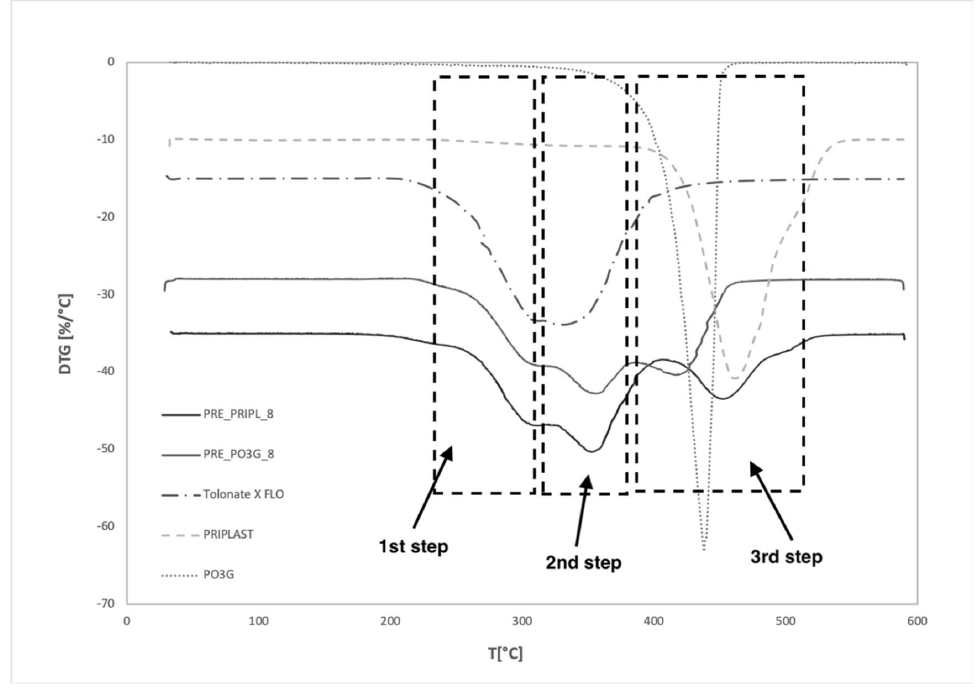
Figure 10. Dependence of DTG in the function of temperature for monomers and the obtained bio  based prepolymers with NCO ca. 8%.